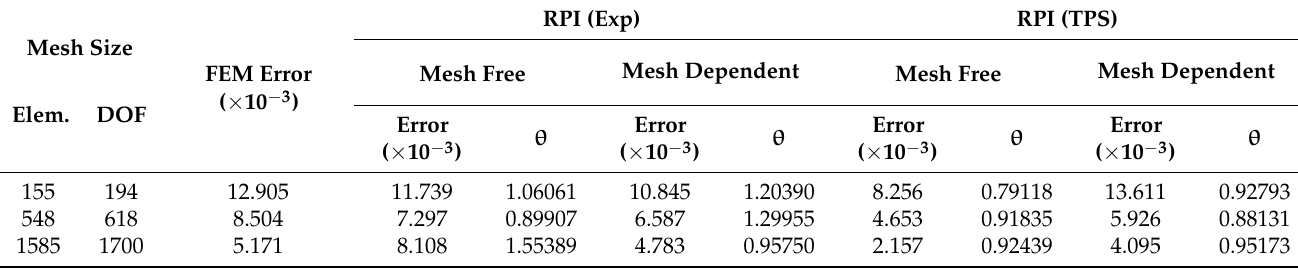
Table 12. Error convergence and global effectivity (θ) for plate problem with hole using exponential (Exp) and thin plate